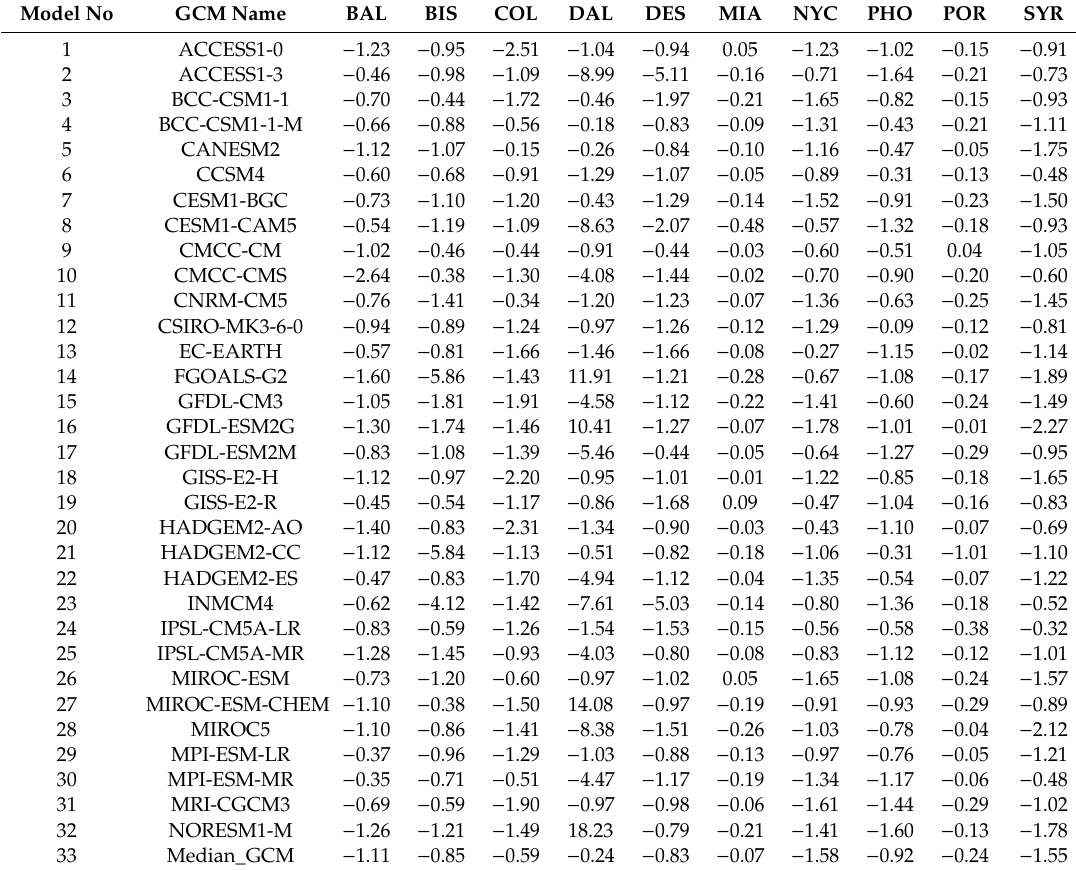
Table A12. NSE coe ffi cient of Last between observed and simulated data (1950–2005).